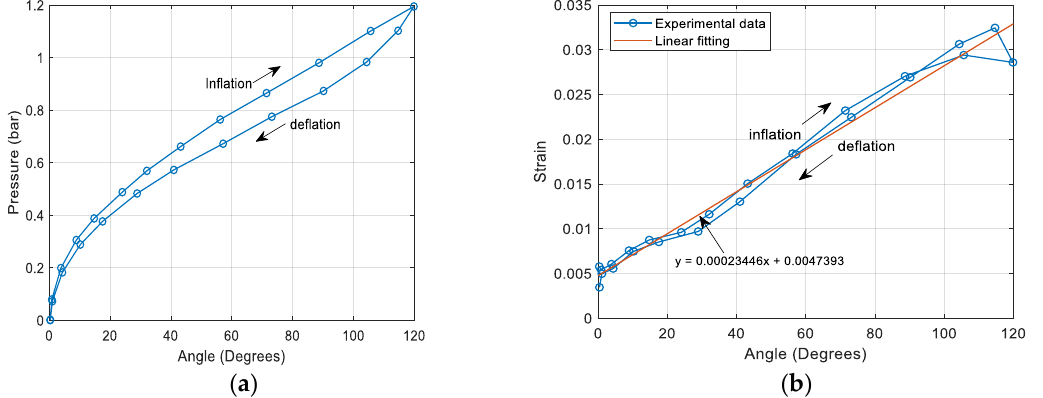
Figure 9. (a) Measured real-time bending angle against the driven pressure from 0 to 1.2 bar. (b) Angle–strain relationship and its linear approximation.